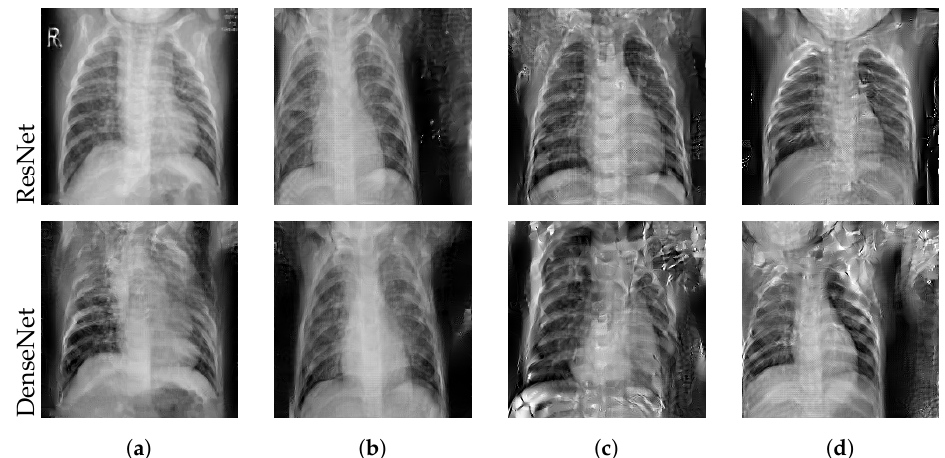
Figure 5. Best reconstructed images out of each batch of size ( a ) 1, ( b ) 2, ( c ) 4, and ( d ) 10. While other samples from those batches were not affected by the attack, the privacy of these examples’ original X-rays has been severely breached, regardless of the batch size.